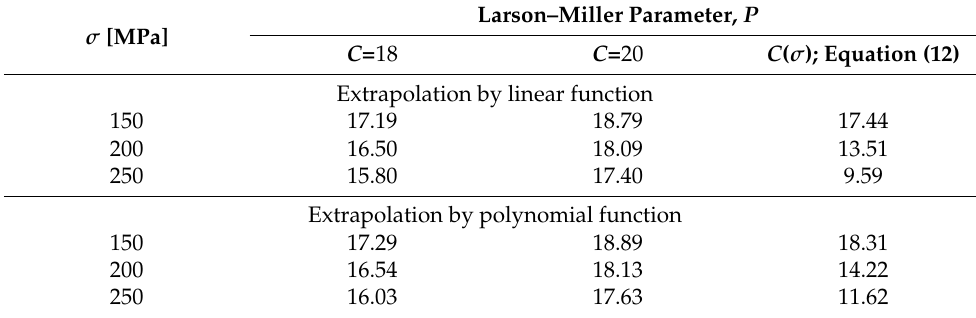
Table 1. P values extrapolated from the input creep data of 10CrMo9–10